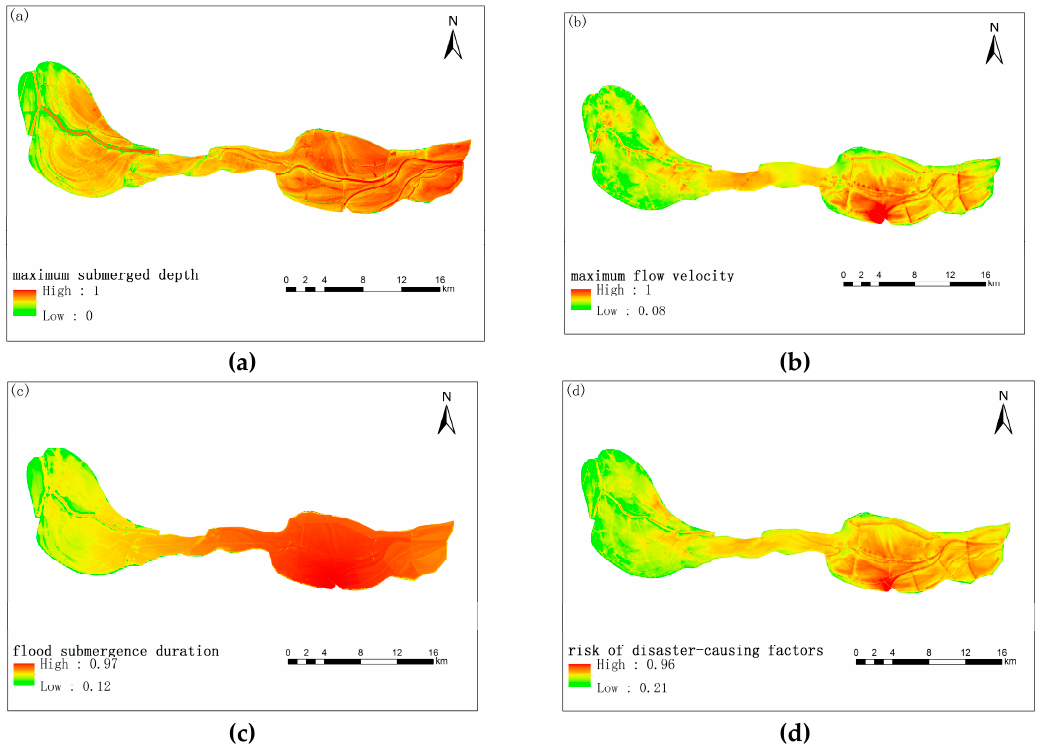
Figure 9. Swallowtail catastrophe calculations for the disaster-causing factors. ( a ) swallowtail catastrophe of the maximum submerged depth, ( b ) swallowtail catastrophe of the maximum flow velocity, ( c ) swallowtail catastrophe of the flood submergence duration and ( d ) risk of disaster-causing factors.